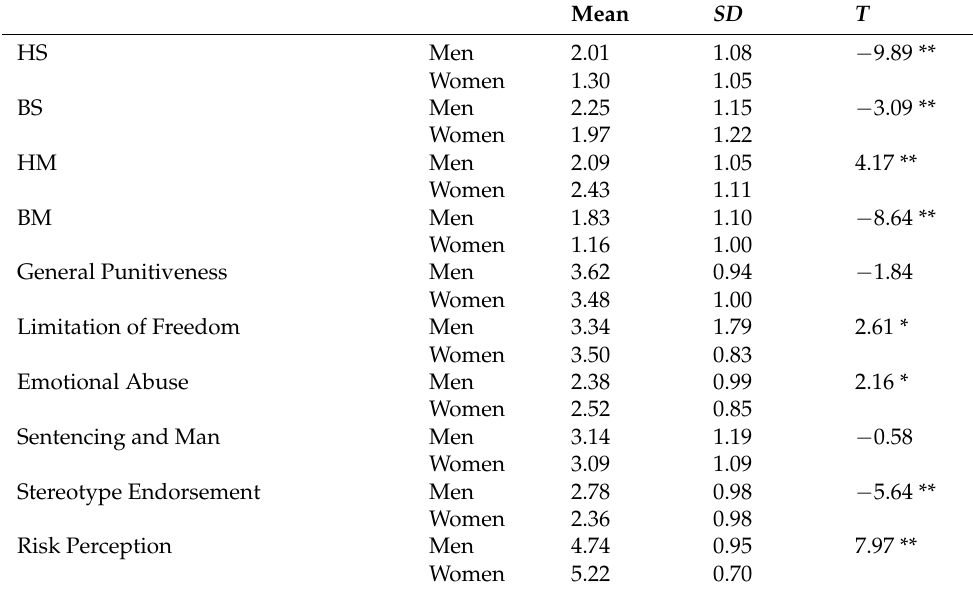
Table 1. Gender differences on the study variables: means, standard deviations, and T -Test scores.